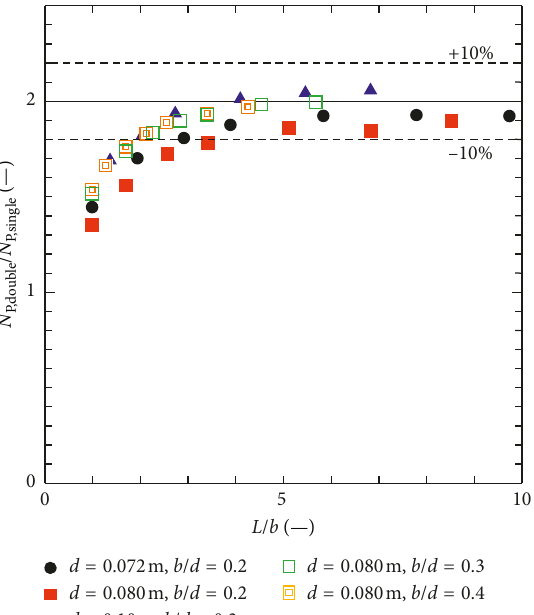
Figure 6: Effect of impeller spacing on power number at Re � 6. The solid line represents the constant value 2. The dotted lines represent the relative error of ± 10% from the solid line.